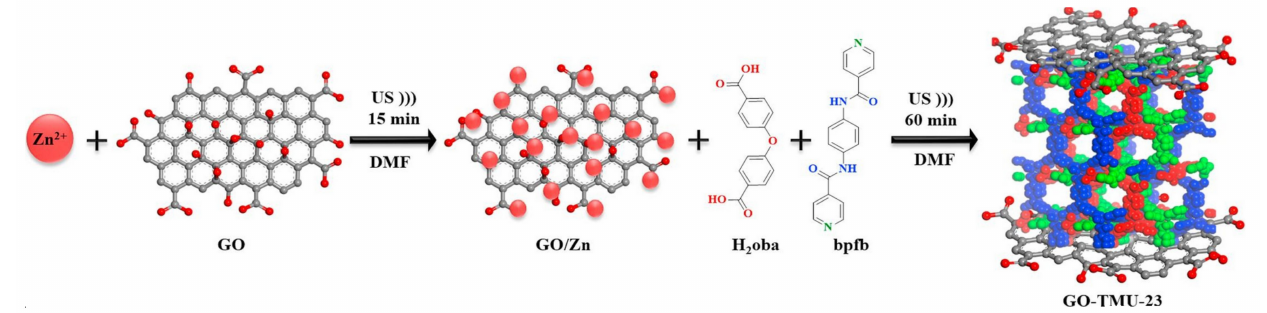
Figure 19. Preparation of the GO-TMU-23 composite adsorbent under ultrasonic irradiation. Reprinted with permis- sion from